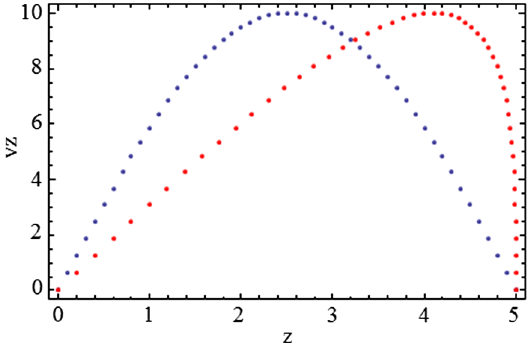
(cid:1) z phase z